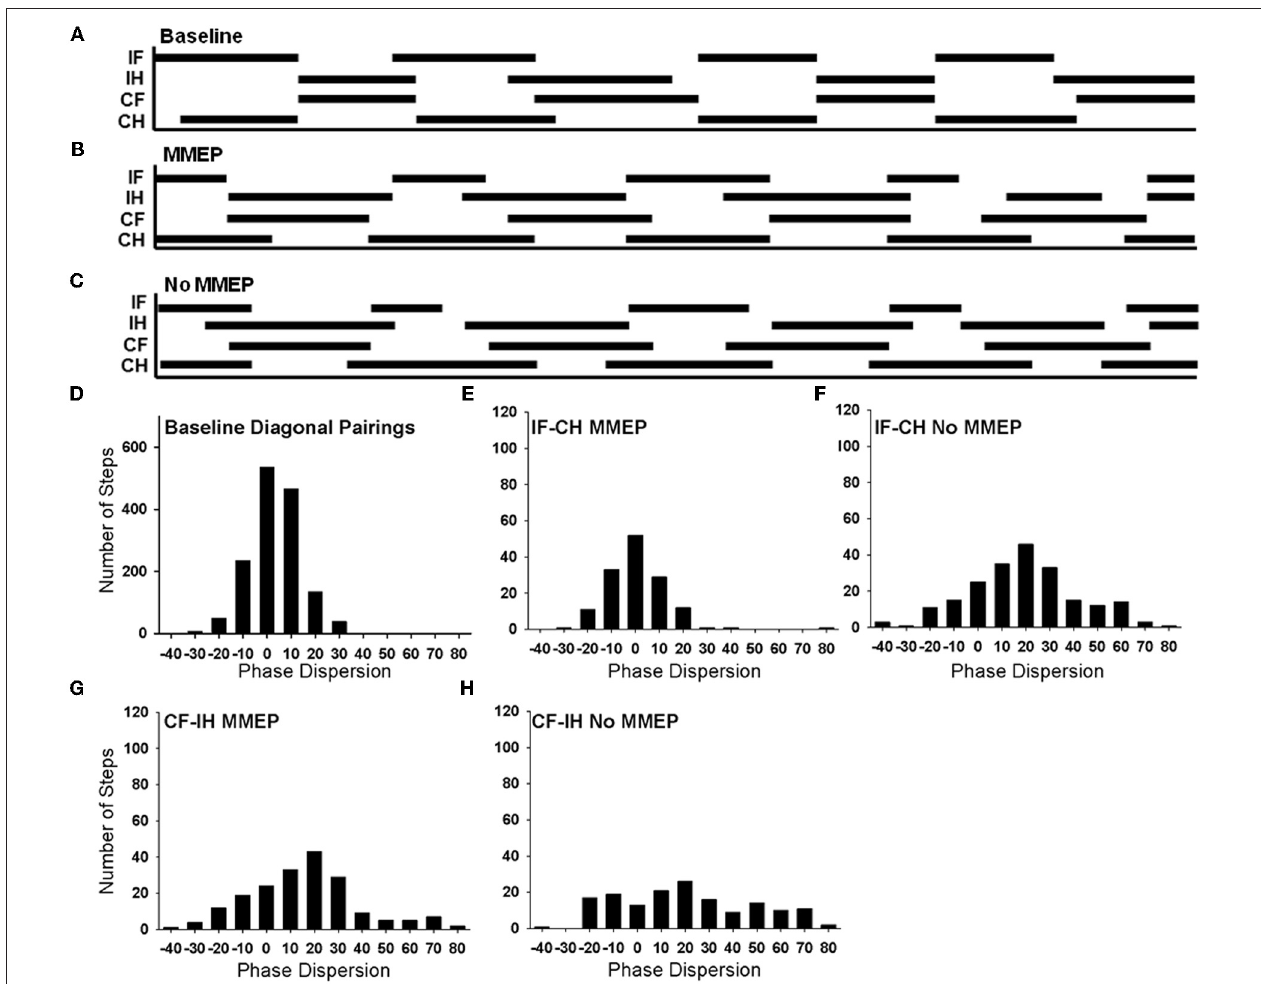
FIGURE 7 | Analysis of forelimb–hindlimb coordination in animals with and without ipsilesional MMEPs 6 weeks after SCI. Footfall diagrams during CatWalk locomotion for normal (A) , SCI animals with (B) , and without (C) ipsilesional MMEP responses allow the comparison of movements of all four limbs (IF, ipsilesional forelimb; IH, ipsilesional hindlimb; CF, contralesional forelimb; CH, contralesional hindlimb). The stance phase of each limb is indicated by black bars and the swing phase is indicated by the open spaces. Overlap of the solid lines for the MMEP and No MMEP groups indicate times when the limbs are moving synchronously. Comparison of the correspondence of stance and swing phase reveals a distribution pattern or phase dispersion for normal animals that centers at 0%, indicating that the initial contact of both diagonal limb pairings are tightly coupled (D) . (E) Animals with ipsilesional MMEP recovered a synchronous coordinative relationship that was similar to